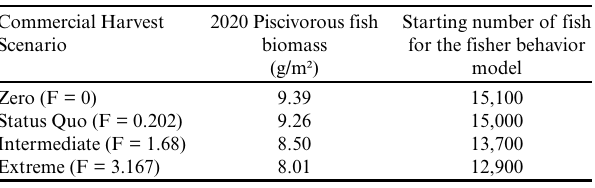
Table 1 . The four scenarios of commercial forage fish harvest, the resulting 2020 piscivorous fish biomass, and the starting number of fish for the fisher behavior model (converted from the piscivorous fish biomass and divided by a factor of